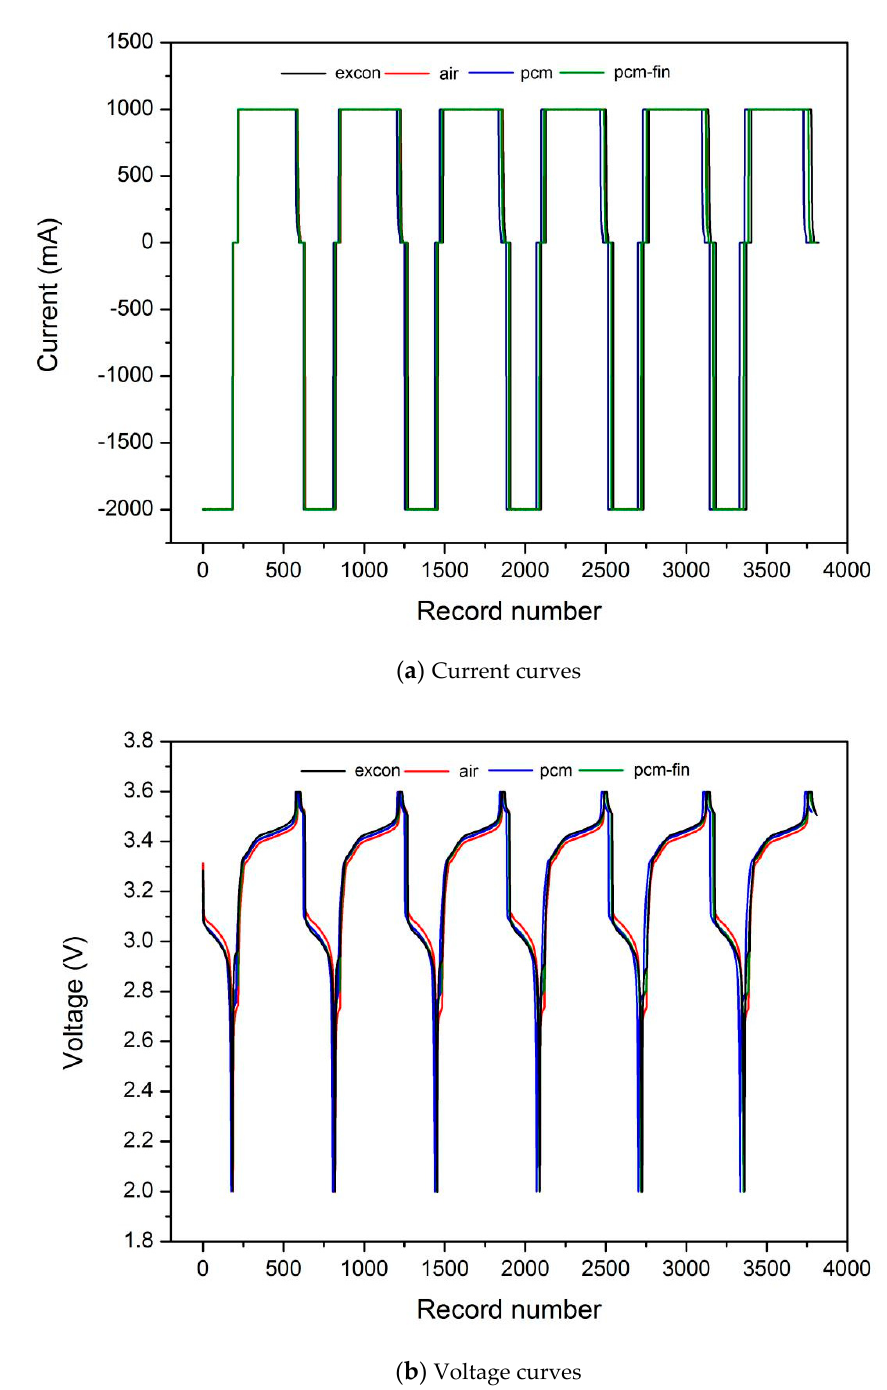
Figure 6. The current and voltage curves of Sony LIB.